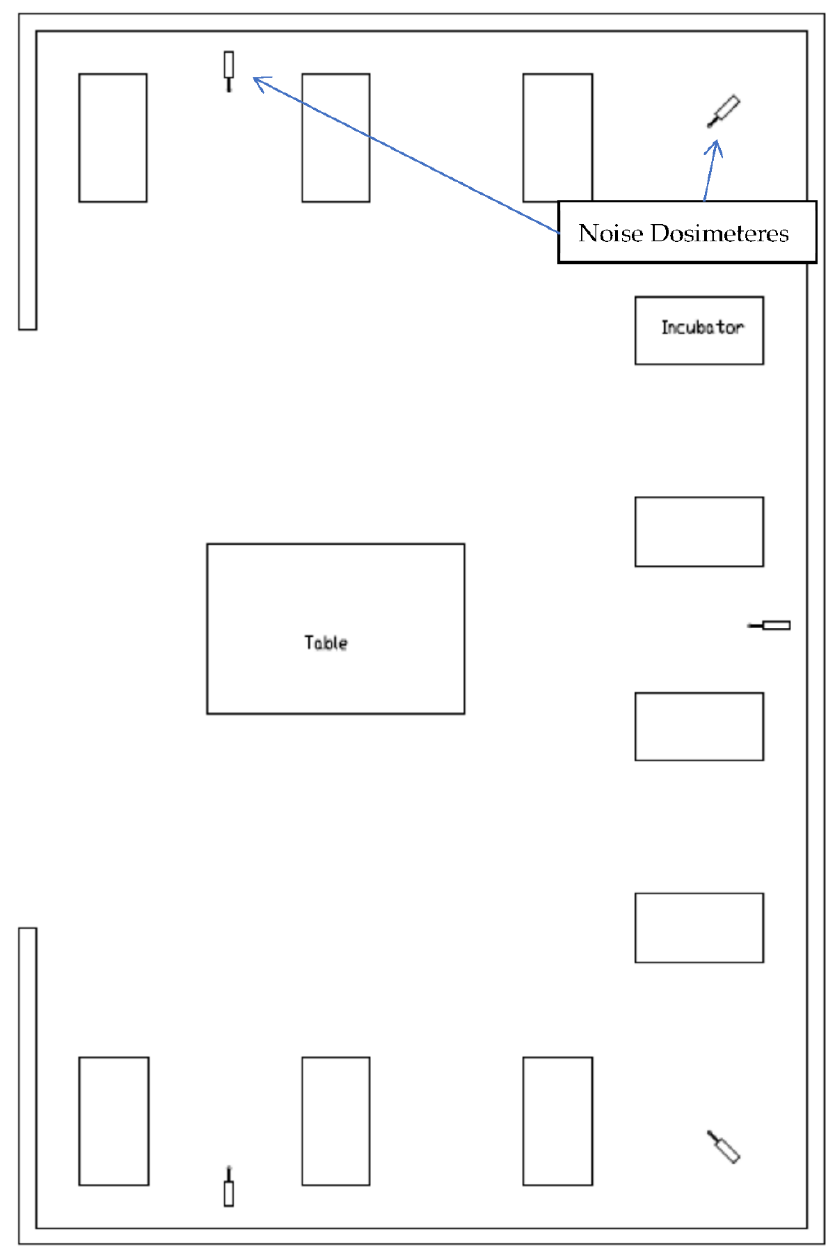
Figure 1. Layout of open bay NICU with 10 incubators.